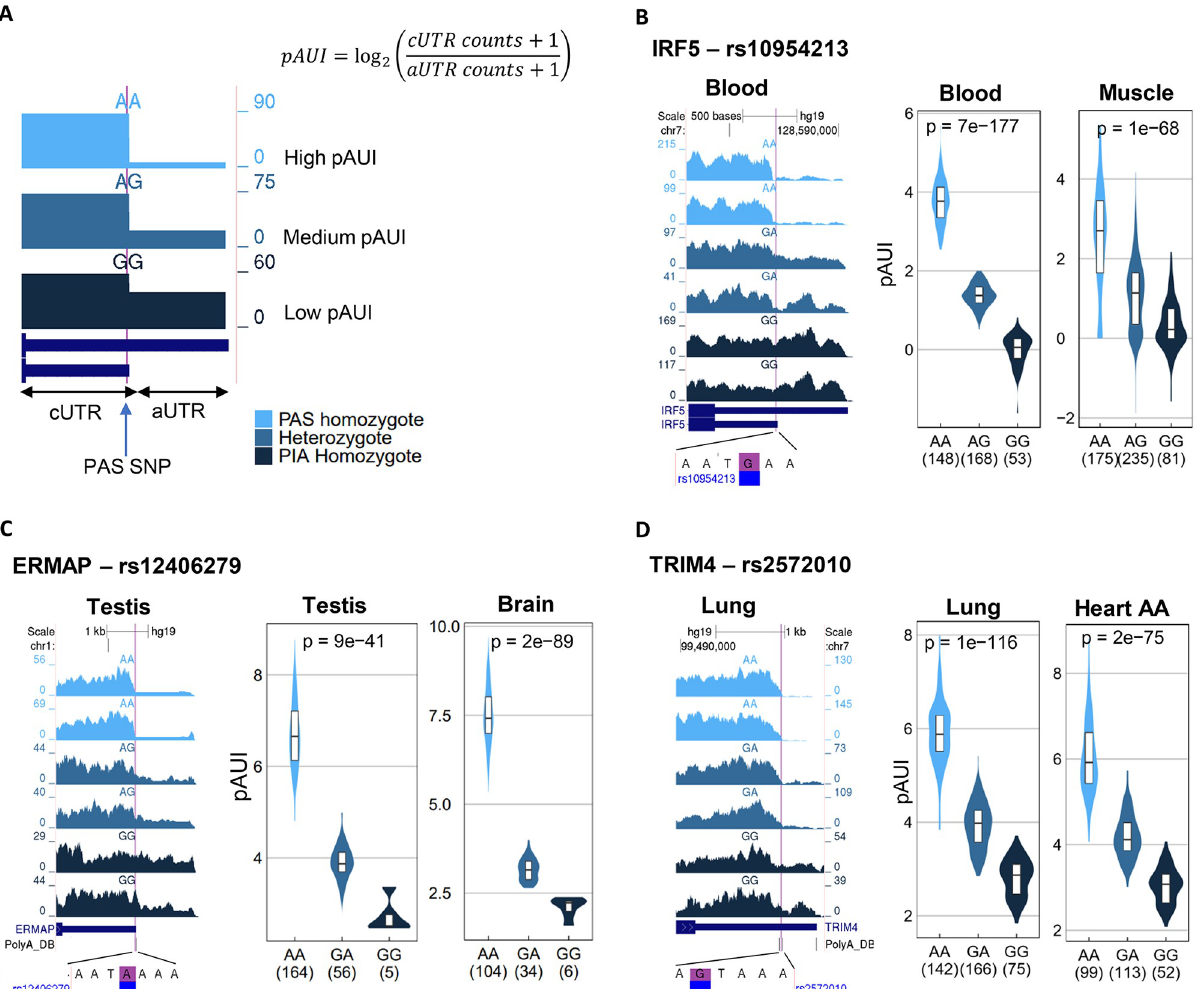
Fig 2. pA-QTL analysis. A . We used the p(A) site usage index (pAUI) to quantify cleavage efficiency at each annotated 3’UTR pA site in each RNA-seq sample. The pAUI is defined as the ratio (in log2 scale) between the counts of 3’UTR reads mapped upstream of the pA site (common 3’UTR segment; cUTR) and those mapped downstream of it (alternative 3’UTR segment; aUTR) (Methods). We then used this index to detect PAS SNPs that show a significant association between alleles and pAUI levels of their p(A) site. SNPs showing such association are referred to as pA-QTLs. The expected pattern, as shown in this cartoon, is that the PAS-preserving allele is associated with higher usage of the p(A) site while the PAS-interrupting allele ( PIA ) is associated with reduced usage of this site (resulting in 3’UTR lengthening). Heterozygotes for such SNPs are expected to show intermediate pAUI levels compared to the two homozygotes. The cartoon illustrates reads coverage on a 3’UTR for three RNA-seq samples of varying levels of pAUI, colored according to the genotype of the PAS SNP. B – D. Examples of three PAS SNPs consistently detected as pA-QTLs in multiple tissues. In each example, the left panel shows read coverage in the gene’s 3’UTR from RNA-seq samples of two selected donors from each PAS SNP genotype. The vertical purple line marks the location of the PAS SNP. The genome reference sequence around the PAS SNP is shown below. Violin plots in the middle and left panels show the distribution of pAUI levels in each genotype group for a given tissue (In each plot, homozygotes of the PAS-preserving allele are shown in the left, heterozygotes–in the middle, and homozygotes to the PAS-interrupting allele (PIA)–in the right violin. The number of individuals in each group is indicated in parentheses, shown are nominal p-values obtained using FastQTL linear regression as described in the Methods). (In C, “Brain” refers to “Brain caudal nucleus”, and in D, “Heart AA” refers to “Heart atrial